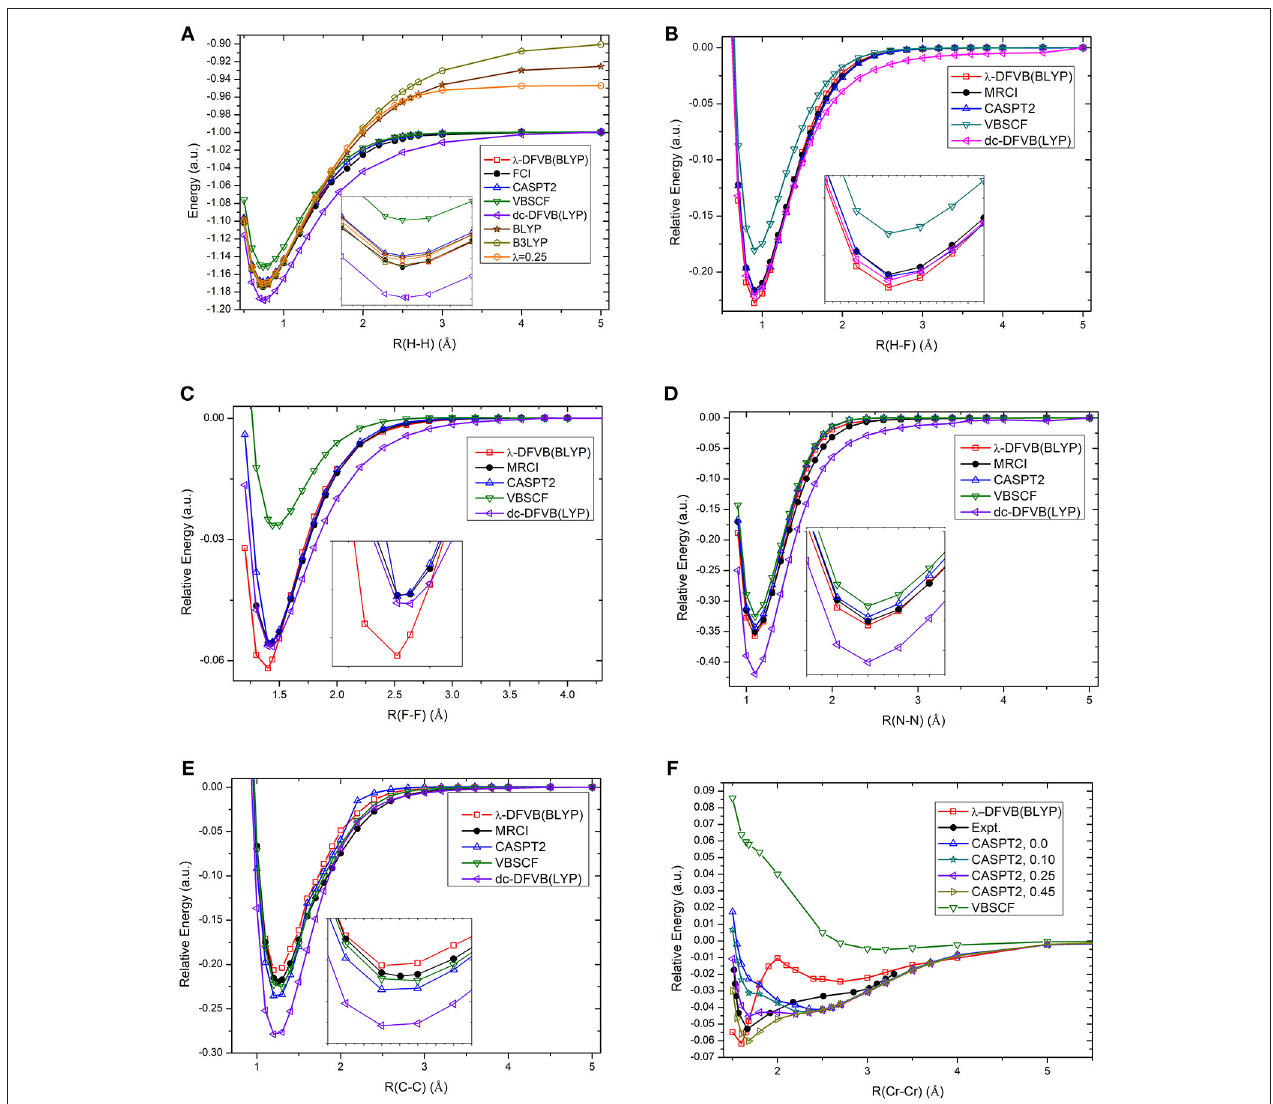
FIGURE 3 | The PES curves of diatomic molecules with various methods: (A) H 2 ; (B) HF; (C) F 2 ; (D) N 2 ; (E) C 2 ; and (F) Cr 2 . The numbers in the brackets after “CASPT2” denote the IPEA